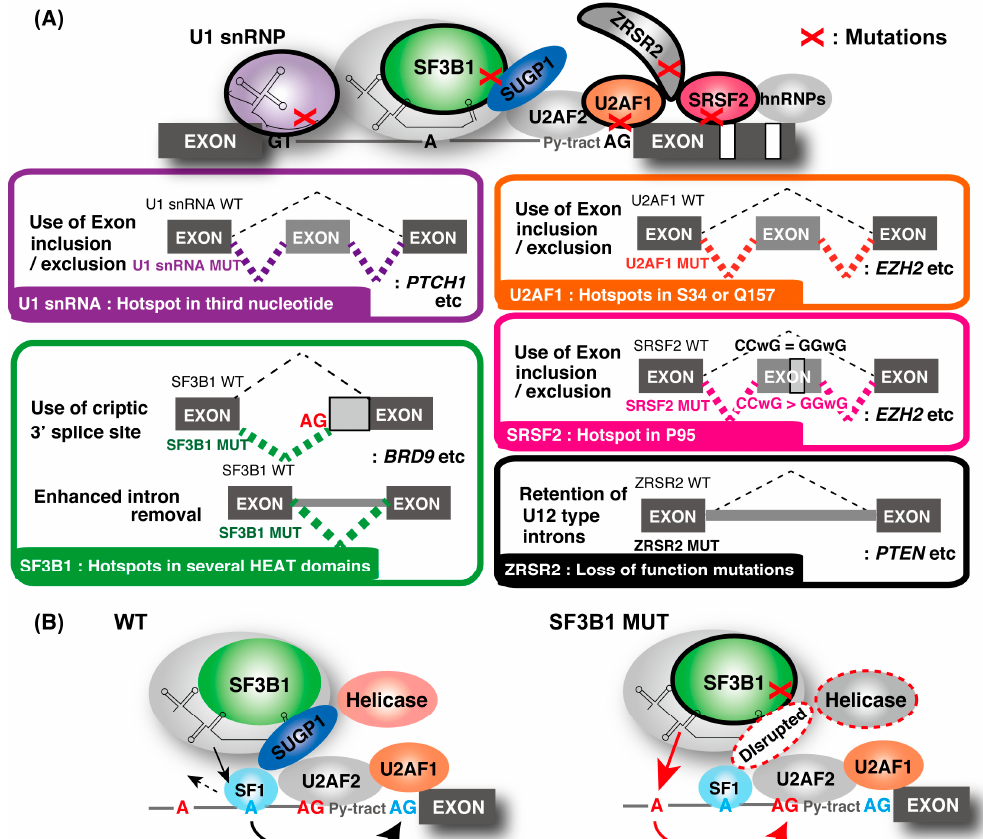
Figure 2. Mutations in splicing factors and their impact on splicing. ( A ) Alteration of splicing caused by splicing factor mutations are shown in the boxes. U1 snRNP: purple, SF3B1: green, U2AF1: orange, Ser / Arg-rich (SR) protein 2 (SRSF2): pink, zinc finger CCCH-type, RNA-binding motif and serine / arginine-rich 2 (ZRSR2): black. Mutations in U1 snRNA cause an alteration in the